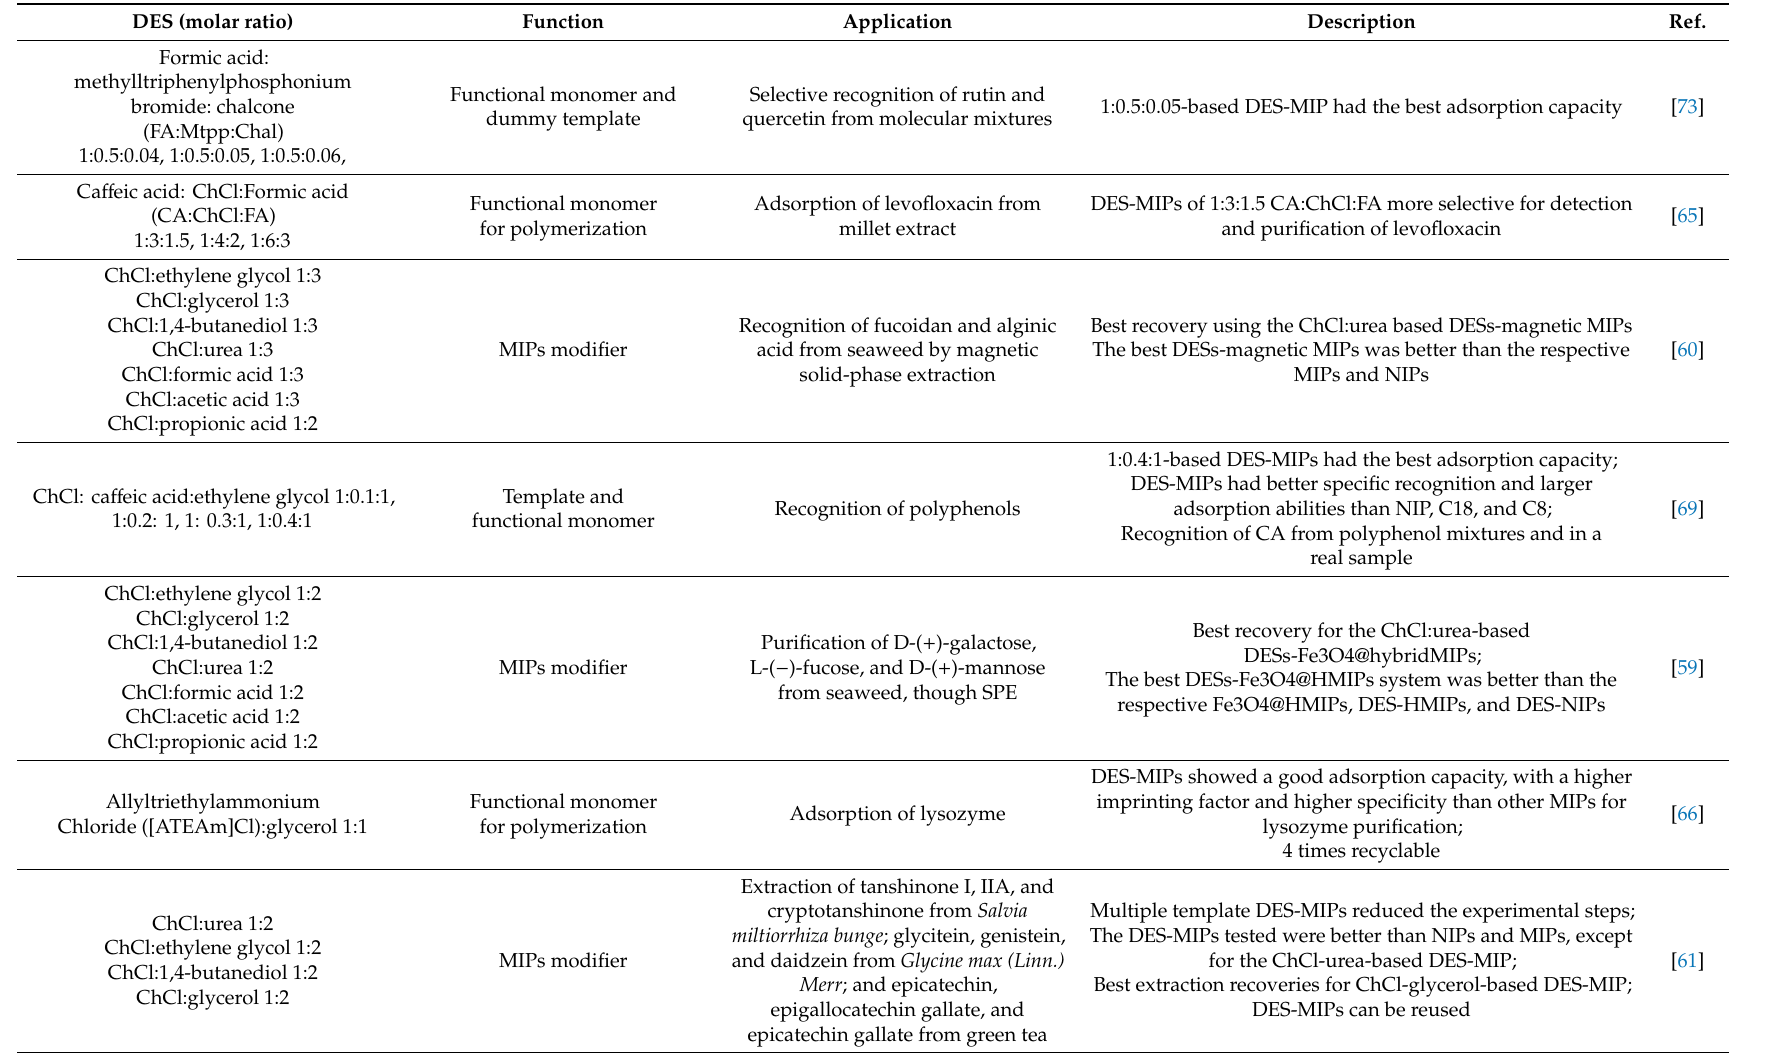
Description Ref.